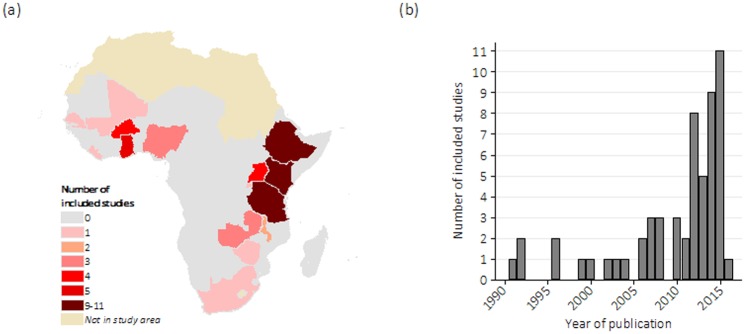
(a) Geographic coverage+ and (b) year of publication of 57 included studies.+Reprinted from Map Maker Limited under a CC BY license, with permission from Map Maker Limited, original copyright 2017.